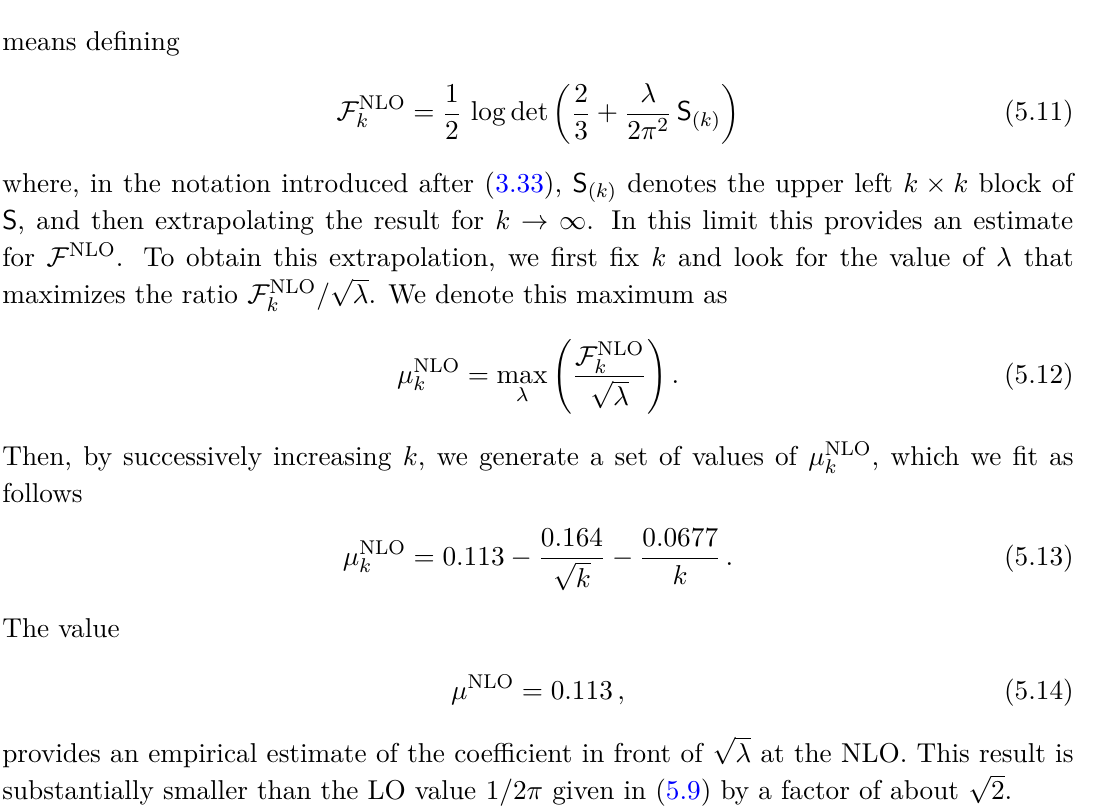
Figure 5 . Padé curve (red curve), MC data and the large- λ theoretical prediction for γ 5 = 1 + ∆ 2 ( λ ) (black dashed curve) in the range 1000 π 2 ≤ λ ≤ 4000 π 2 . As N increases, the MC points systematically tend towards the Padé